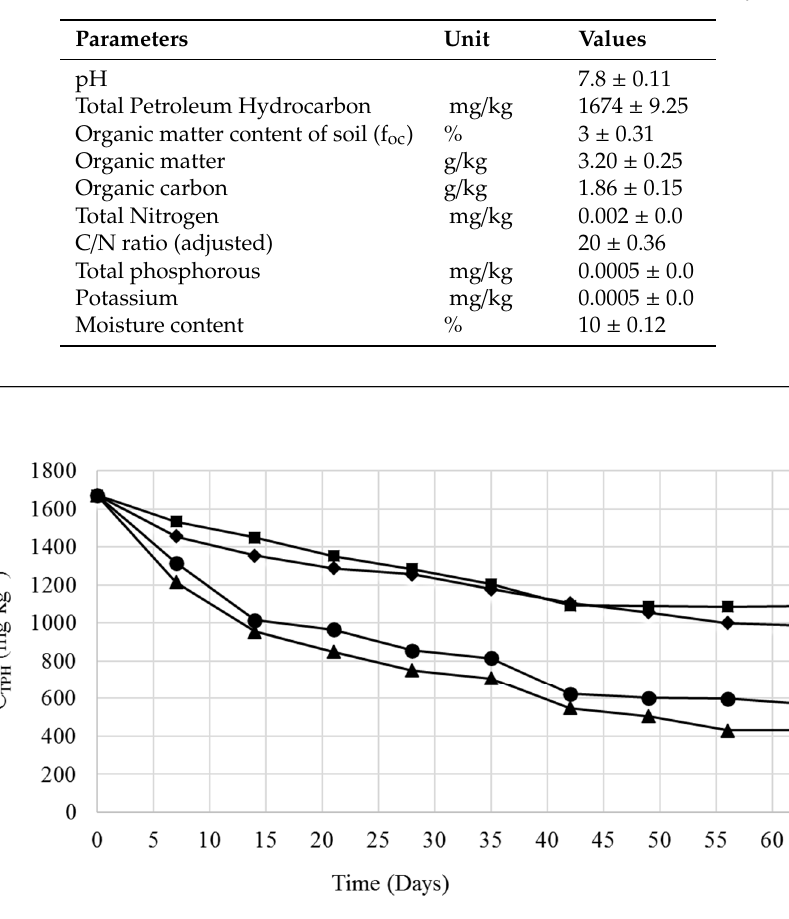
Figure 3. Olympus U ‐ pot microscope picture of the microbial inoculum at 40X magnification.